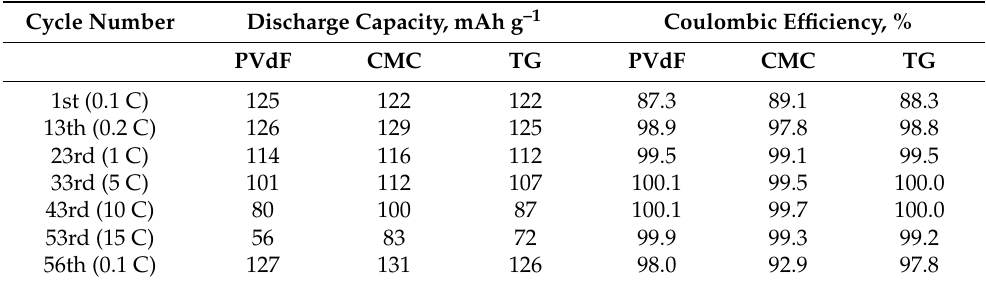
Table 2. Summary of discharge-capacity and coulombic-efficiency performance at different C-rates of LNMO electrodes with different